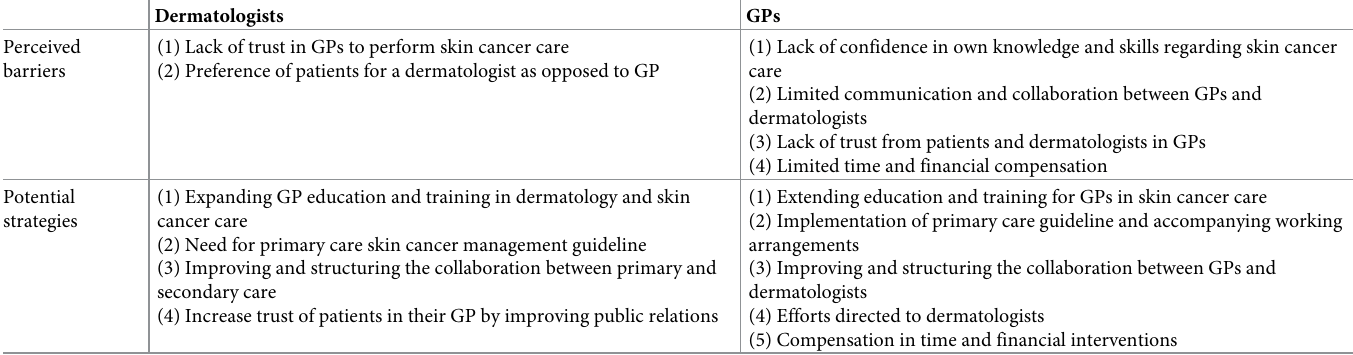
Table 2. Overview of the perceived barriers and potential strategies regarding substitution of care as expressed by dermatologists and GPs in the interviews.